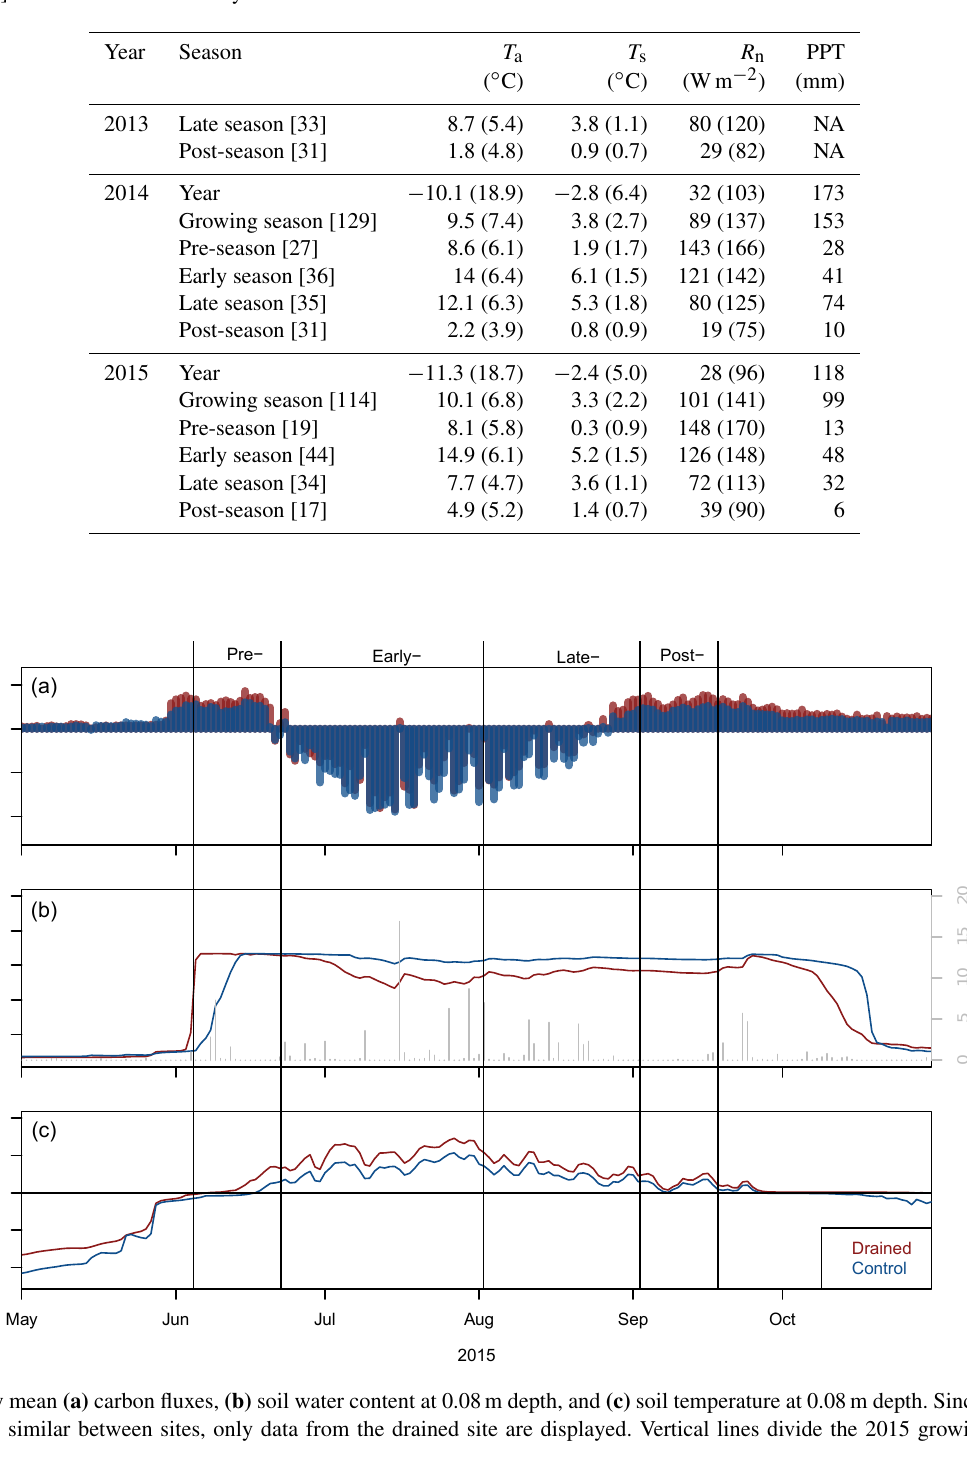
Table A1. Environmental conditions measured at Tower 1 (drained): air temperature ( T a ) at a 2m height, soil temperature ( T s ) at a 0.8m depth and net radiation ( R n ). Values are given as mean ( ± SD), with the exception of precipitation (PPT, sum per season). Measurements from 2013 started mid-July (late season); no data are therefore available before this time. The growing season is divided into sub-seasons; [length of season] is the total number of days.